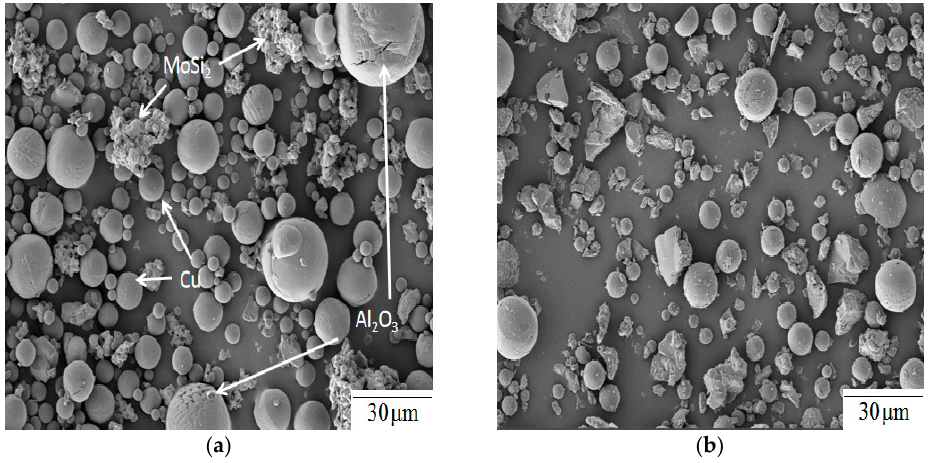
Figure 1. SEM micrographs of Al 2 O 3 -MoSi 2 -Cu mix powders: ( a ) the original powders; ( b ) ball milling for 4 h after spray feedstock.